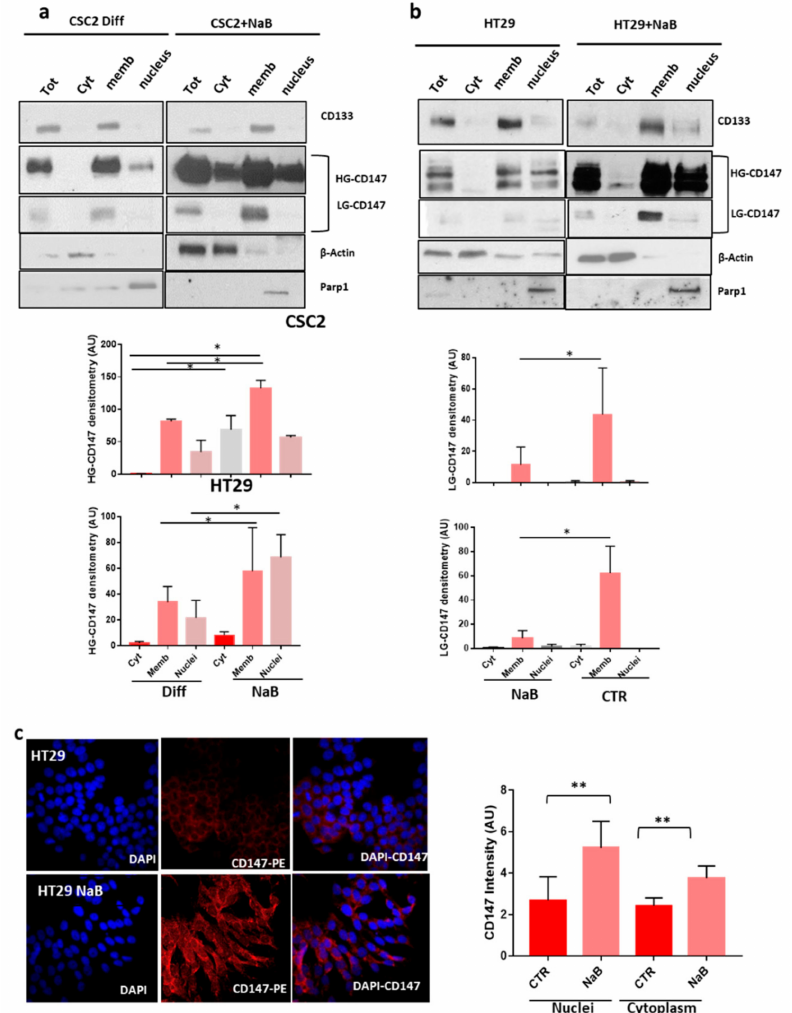
Figure 5. Characterization of CD147 Subcellular Localization In CR-CSC (colorectal cancer stem cell) and HT29 Cell Lines. ( a , b ) CD147 expression was analyzed in total cell extracts (Tot) and in the cytoplasmic (Cyt), membranous (Memb) and nuclear (nuclei) fractions of the indicated cell lines. E ffi cacy of subcellular fractionation is indicated by cytoplasmic marker protein actin, membrane marker protein CD133, and nuclear marker protein Parp1. HG-CD147 was mainly expressed in membrane and nuclear fractions and increased in di ff erentiated cells. Expression of LG-CD147 was confined only to membrane in both cancer cell line and did not change upon di ff erentiation. Bar charts show the densitometry and statistical analyses of CD147 bands. ( c ) Immunofluorescence staining of CD147 in HT29 cancer cell lines treated with NaB compared to untreated cells. DAPI (4 (cid:48) ,6-diamidino-2-phenylindole, blue) stains the nuclei; anti-CD147 antibody is labelled with phycobiliprotein (PE) (red), magnification 600 × . Bar charts showing the intensity of CD147 staining in nuclei and cytoplasm. Data are representative of three independent experiments. *, p ≤ 0.05; **, p ≤